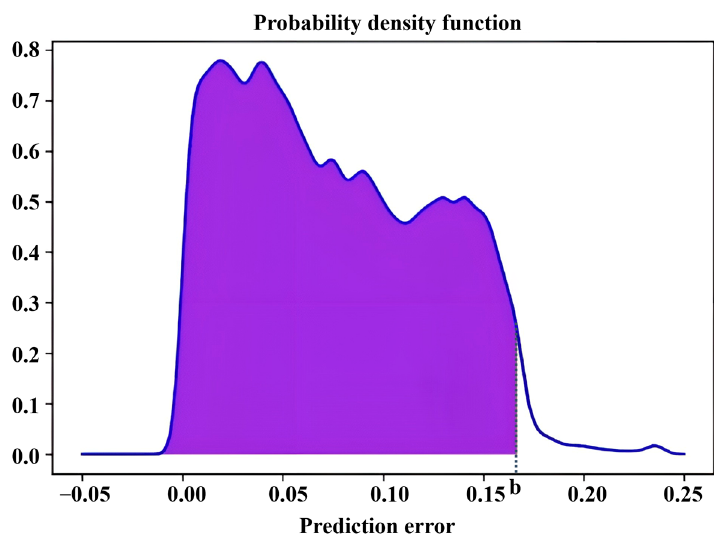
Figure 19. Fitted probability density function of prediction error.